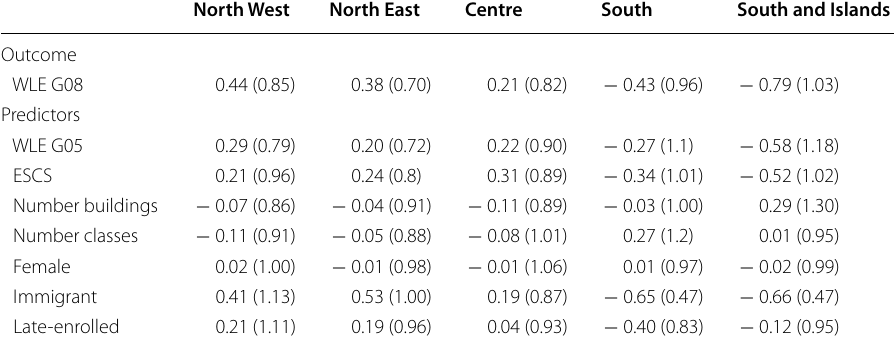
Table 1 Descriptive statistics, mean and (standard deviations), on the outcome and the standardized predictors by geographical area (North West, North East, Centre, South, South and